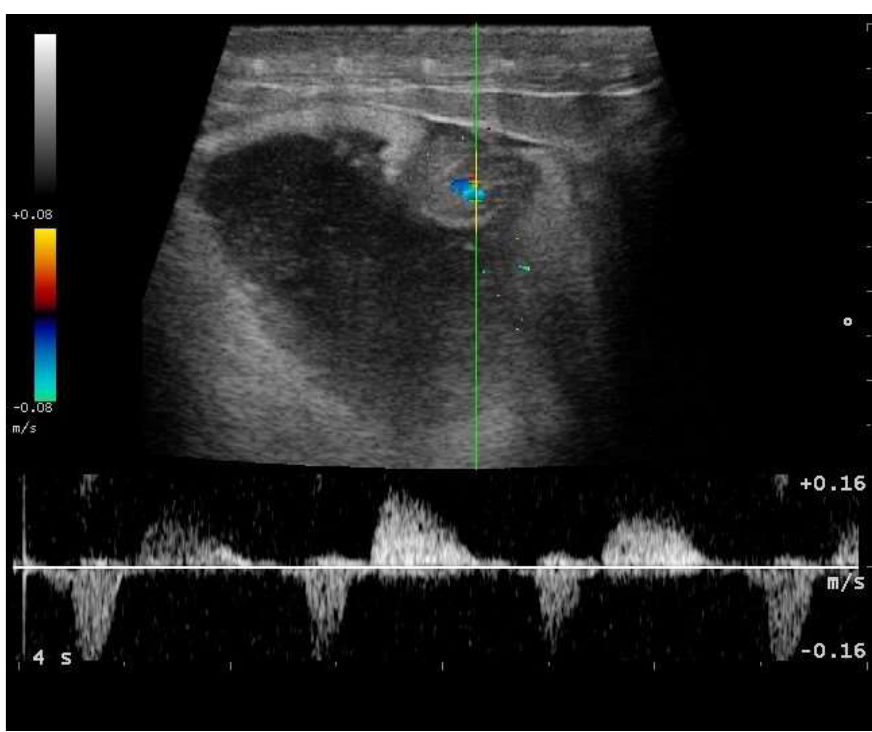
Figure 12. Gravid female boa 42 days after ovulation—flow towards the transducer is depicted in red, while flow away from the transducer is shown in blue. Through Doppler, it was possible to highlight embryonic blood flows and heart activity in 100% of females who gave birth to live and viable offspring.